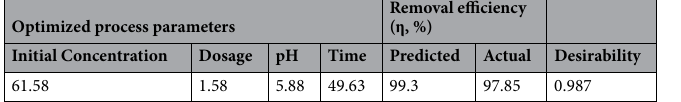
Table 5. Optimal conditions of the selected factors for Cd adsorption via